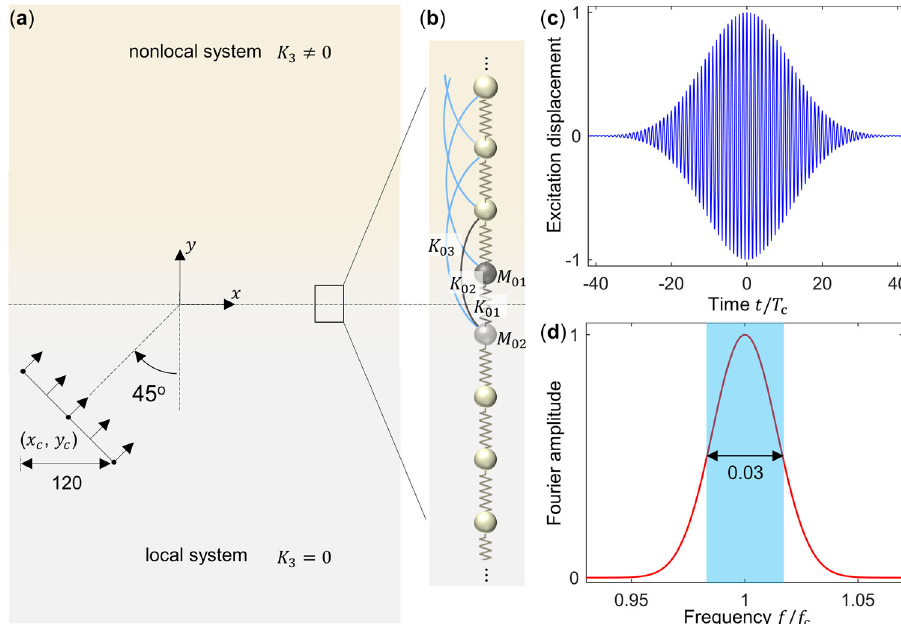
Fig. 7 Simulation setup of wave refraction at interface. a Wave transmission at an interface between a local system with only nearest-neighbor interactions (bottom, gray) and a nonlocal system additionally including third-nearest-neighbor interactions, K 3 ≠ 0 (top, yellow). The incident wave impinges under an angle of 45 (cid:6) onto the interface. b Due to the mismatch of interaction orders between the two regions, some of the third-order Hooke ’ s springs are cut away near the interface (dashed horizontal line) within the nonlocal region. To control the transmission of the incident waves, we fi ne-tune the mass parameters, M 01 and M 02 , and three Hooke ’ s spring constants, K 01 ; K 02 , and K 03 , at the interface. To avoid re fl ection of the partial waves at the boundaries of the simulation domain, we choose a much larger simulation domain than the one shown. A wave packet that is Gaussian in space and time is launched by prescribing the pressure in Eq. (4) on the black lines according to cos 2 π f c t